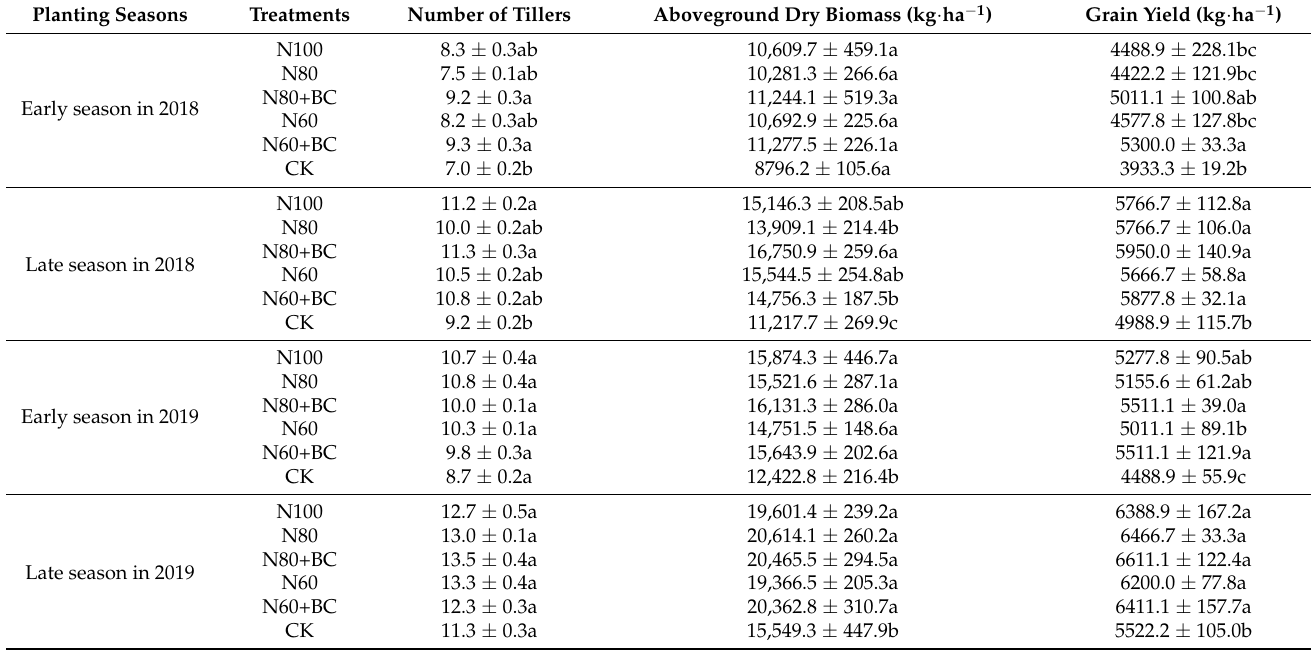
Table 1. Effects of N fertilizer reduction combined with biochar application on the number of tillers, aboveground dry biomass, and grain yield of rice.